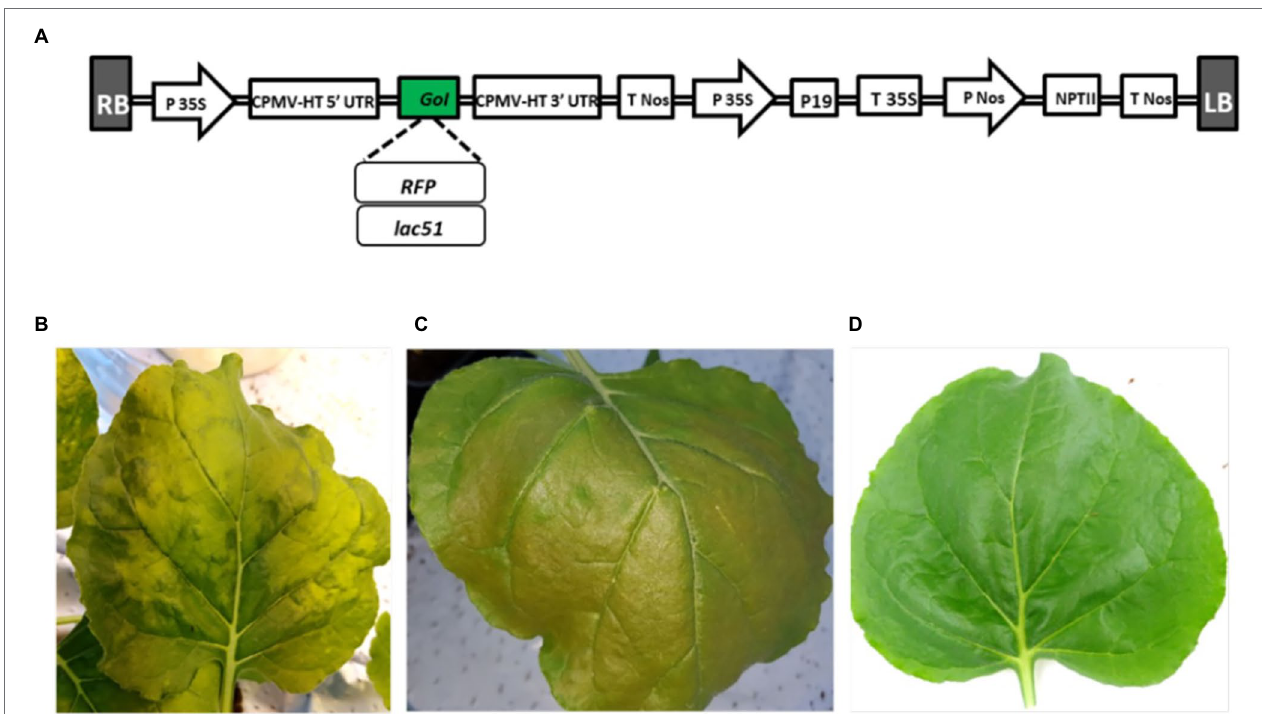
FIGURE 1 | Expression of Lac51. (A) Schematic illustration of lac51 and red fluorescent protein ( RFP ) gene expression vectors. The Lac51-encoding gene was introduced into the pEAQ-HT-DEST1 vector using Gateway cloning technology. RB and LB, right and left borders; CPMV-HT 5 ′ UTR and 3 ′ UTR, 5 ′ and 3 ′ untranslated regions derived from Cowpea mosaic virus (CPMV); P 35S and T 35S, 35S promoter and terminator; P Nos and T Nos, nopaline synthase promoter and terminator; P19, suppressor of gene silencing; NPTII, neomycin phosphotransferase II gene conferring kanamycin resistance. (B–D) Phenotype of Nicotiana benthamiana leaves expressing lac51 (B) and the rfp reporter gene (C) , where the latter gives a distinguishable red color, at 5 dpi, as compared to a leaf infiltrated only with buffer as control (D)